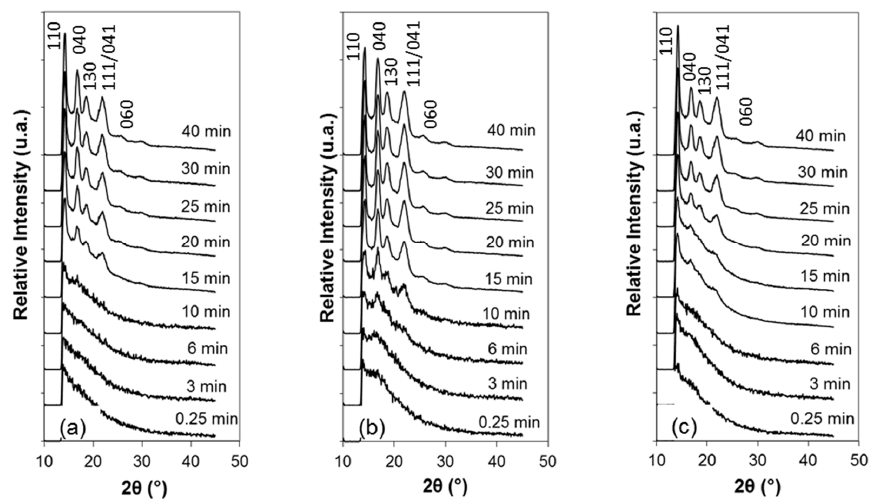
Figure 4. RT-WAXS patterns of the iPP wax–sorbitol compounds during in situ crystallization at 135 °C; ( a ) iPP wax–DBS, ( b ) iPP wax–MDBS and ( c ) iPP wax–DMDBS.